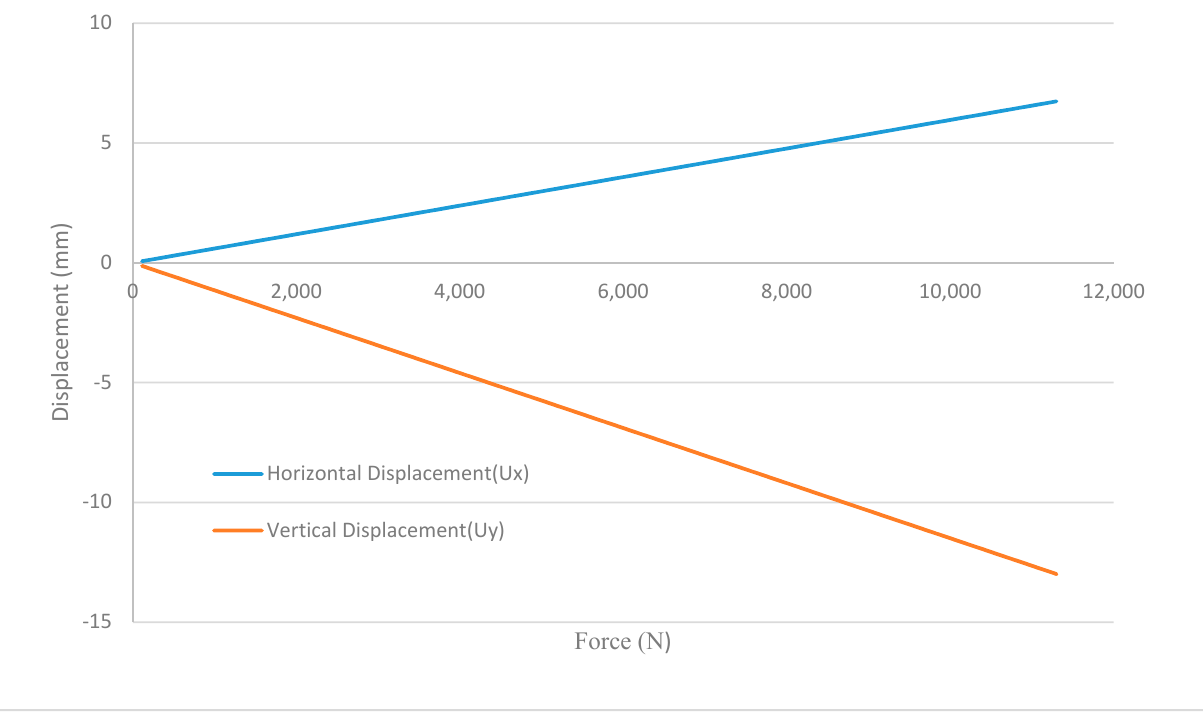
Figure 20. Horizontal and vertical displacements at node 20, element 1126 with coordinate details: ( x = 0, y = 0.25, z = − 4) and 20% FA.